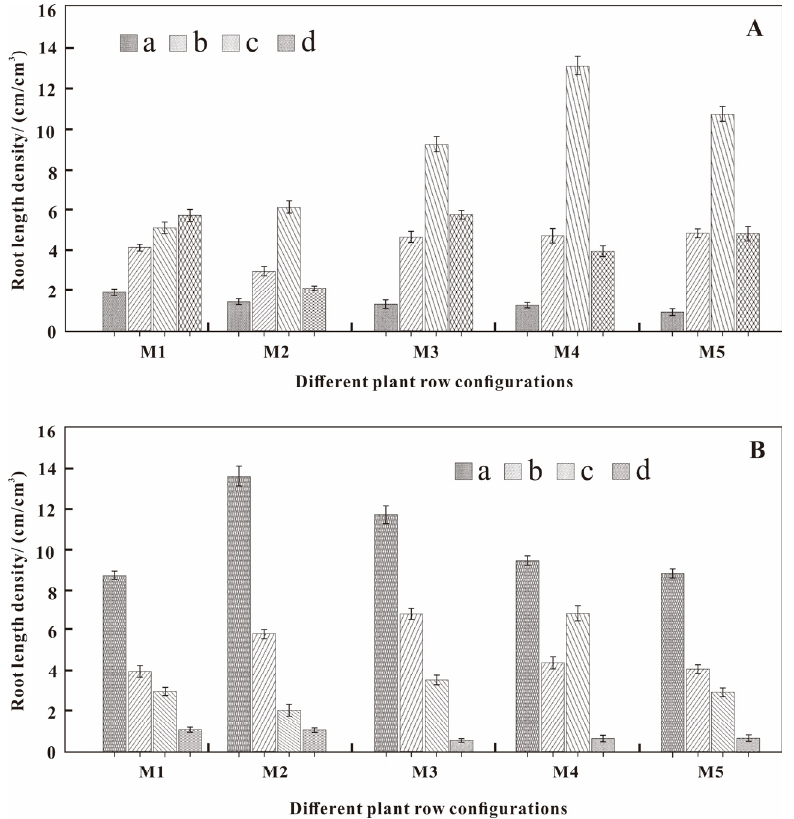
Figure 3. Distribution characteristics of root length density at different growth stages (a: Overwintering, b: Jointing, c: Heading, d: Ripening). ( A ) Multi-spike wheat. ( B ) large-spike wheat.